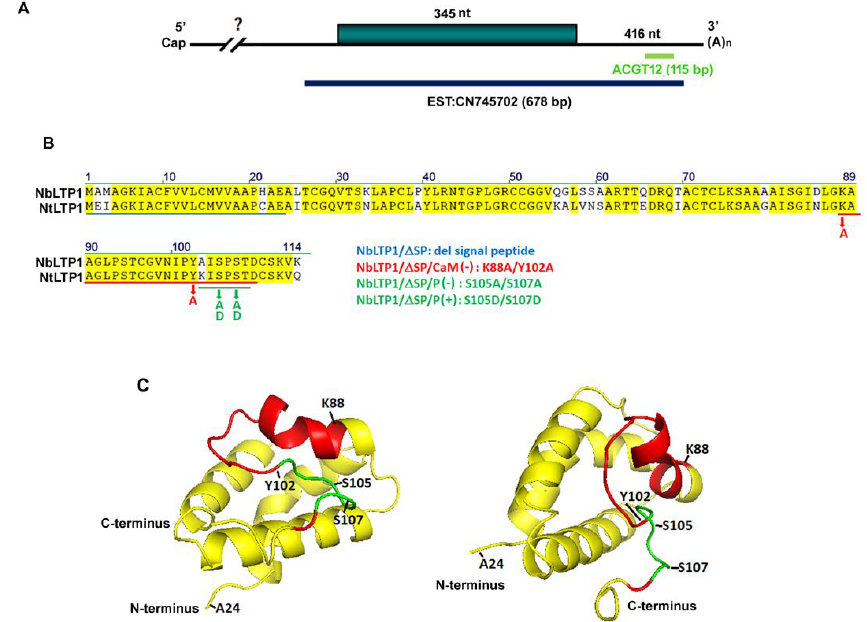
Figure 1. Illustration of the cDNA organization of NbLTP1 and its structural characters. ( A ) The cDNA of NbLTP1 with an open reading frame is indicated. The DNA fragment ACGT12 cloned from cDNA-AFLP and the DNA fragment revealed in the N. benthamiana -expressed sequence tag (EST with clone name CN745702) are indicated. ( B ) The sequence of NbLTP1 and alignment with NtLTP1. The alignment of the amino acid sequence of NbLTP1 derived from Nicotiana benthamiana (GenBank: CN745702) and Nicotiana tabacum (GenBank: Q42952.1). The signal peptide (1 to 23) is underlined in blue, the calmodulin-binding site is in red, and the phosphorylation signal is in green. Mutant constructs are indicated. ( C ) The three-dimensional modeling of the NbLTP1 is simulated by the Phyre2 server (http: // www.sbg.bio.ic.ac.uk / ~phyre2 / html / page.cgi?id = index). The